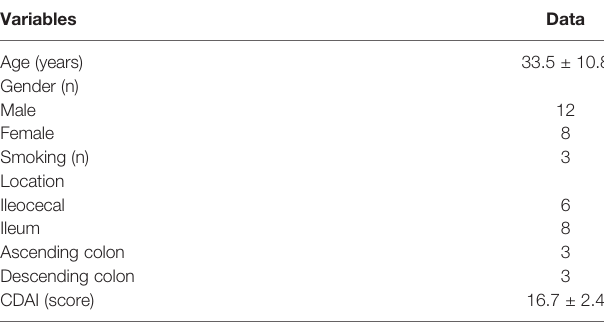
TABLE 3 | Demographic data of CD patients.